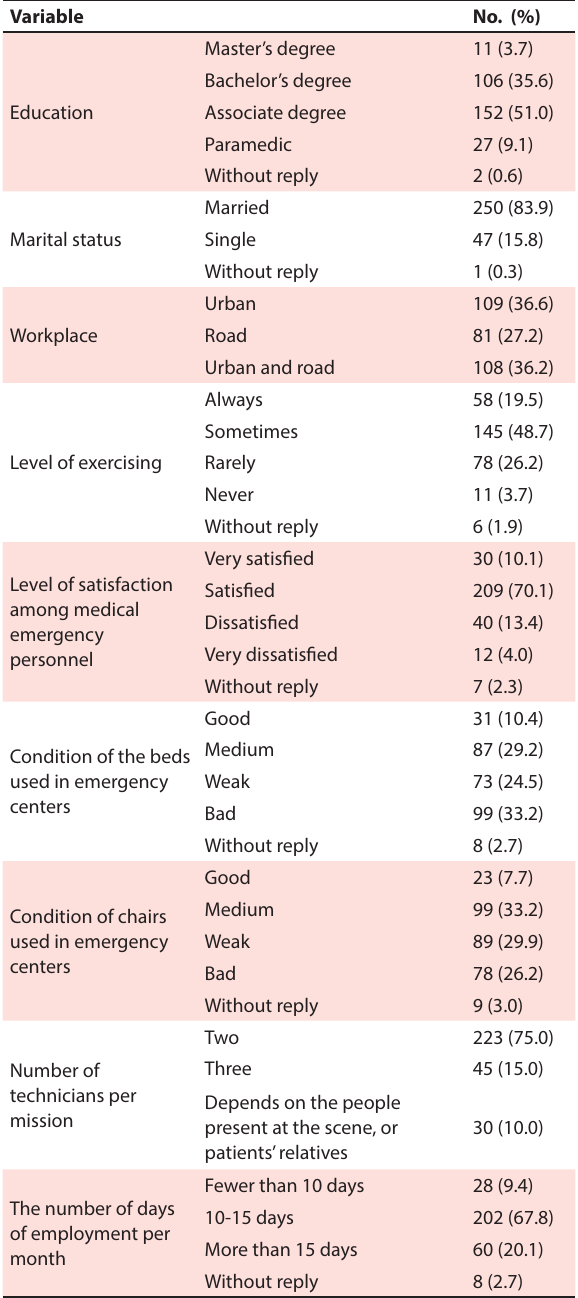
Table 1. Demographic characteristics of the technicians participating in the study (N = 298)